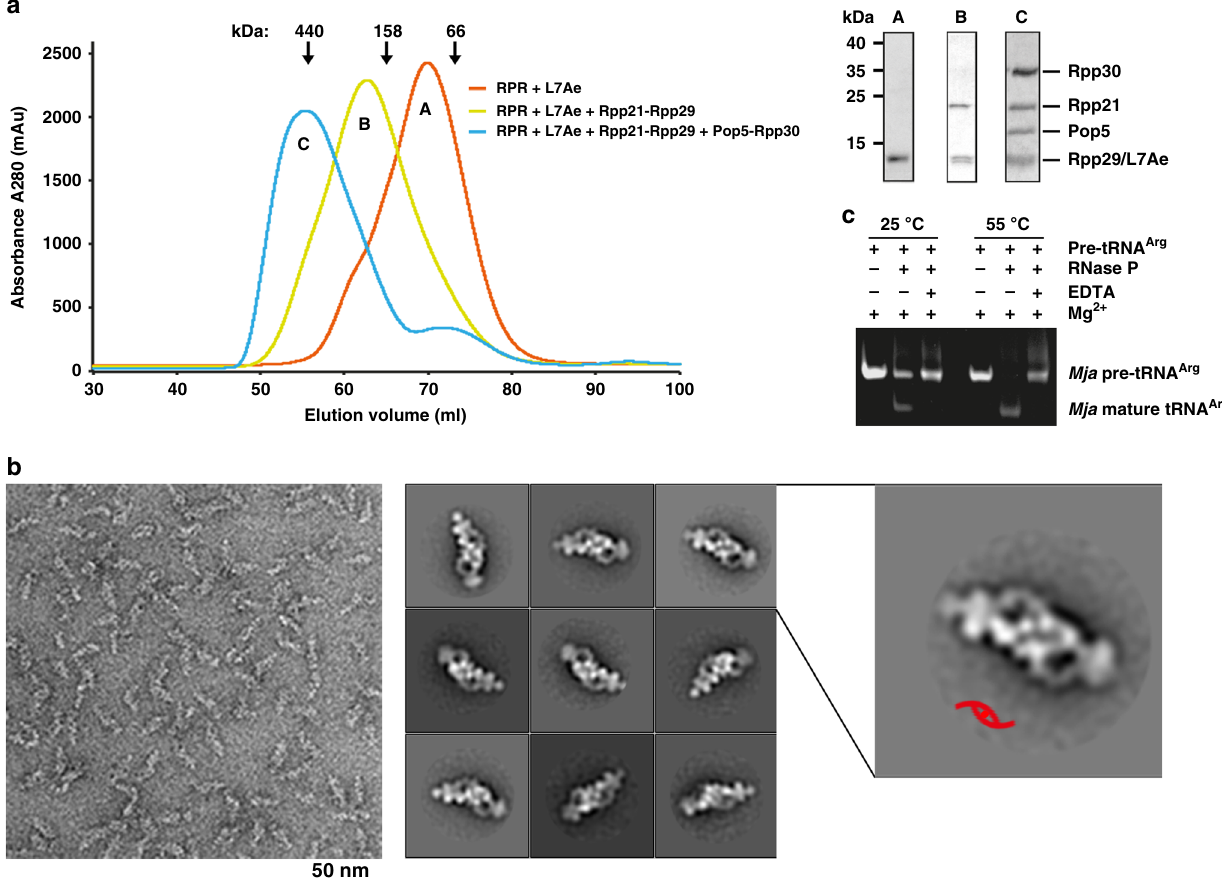
Fig. 1 In vitro reconstitution of the Mja RNase P holoenzyme. a Size exclusion chromatographic pro fi les (left) and Coomassie-stained SDS-PAGE of the corresponding peaks in the pro fi les (right). b Negative staining EM analysis of Mja RNase P. Left: A representative negative-stained EM micrograph of Mja RNase P. Middle: Selected 2D class averages of Mja RNase P. Right: Close-up view of the 2D class averages with the C2 symmetry denoted a red symbol. c In vitro pre-tRNA Arg processing assay of the Mja RNase P